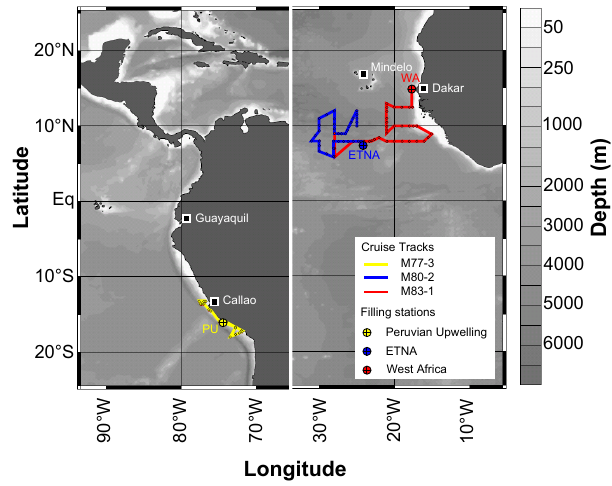
Fig. 1. Map of the tropical Pacific and Atlantic showing filling sta- tions of the mesocosms (crossed circles) plus the following cruise track during the time of experiments (dots) at the respective cruise. Yellow markers denote cruise M77-3 (PU), blue M80-2 (ETNA) and yellow M83-1